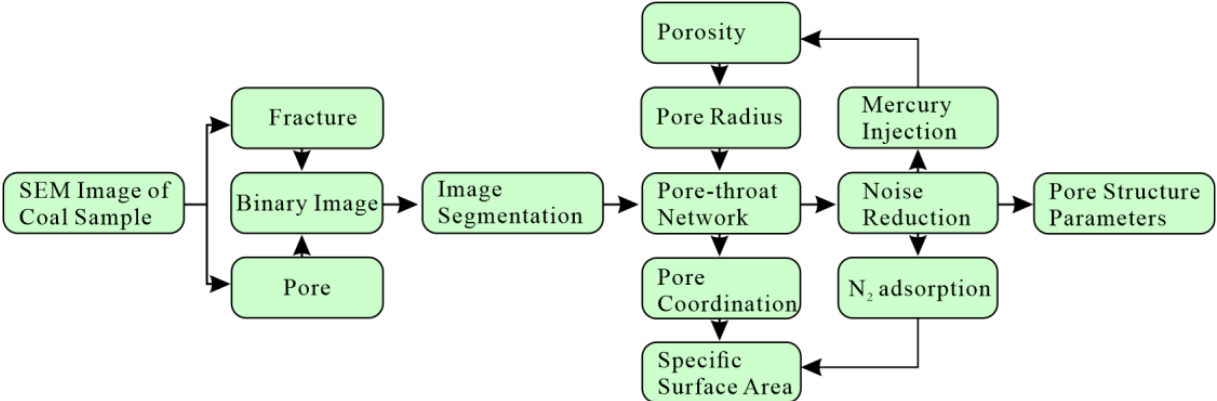
Figure 1. The flow chart of quantitative analysis of various pore structure parameters based on the SEM image of the coal reservoir.